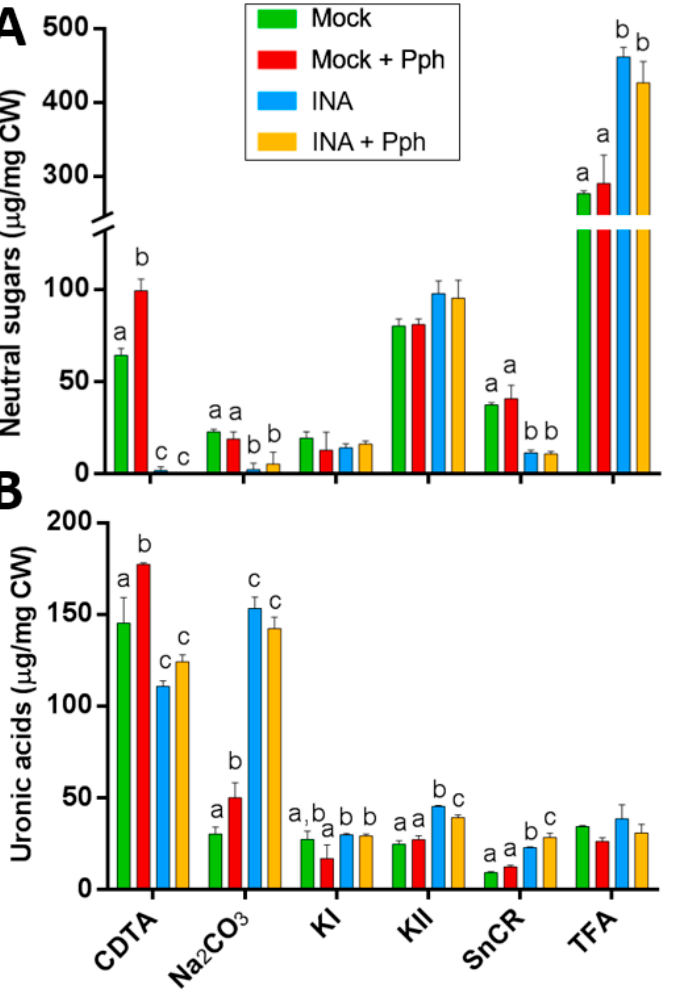
Figure 5. Biochemical composition of CW fractions from Mock, Mock + Pph, INA and INA + Pph inoculated common bean plants: ( A ) neutral sugars and ( B ) uronic acid content. Data represent mean ± SE ( n = 3). Statistical analysis was carried out by one-way ANOVA where letters indicate differences by Tukey test ( p <